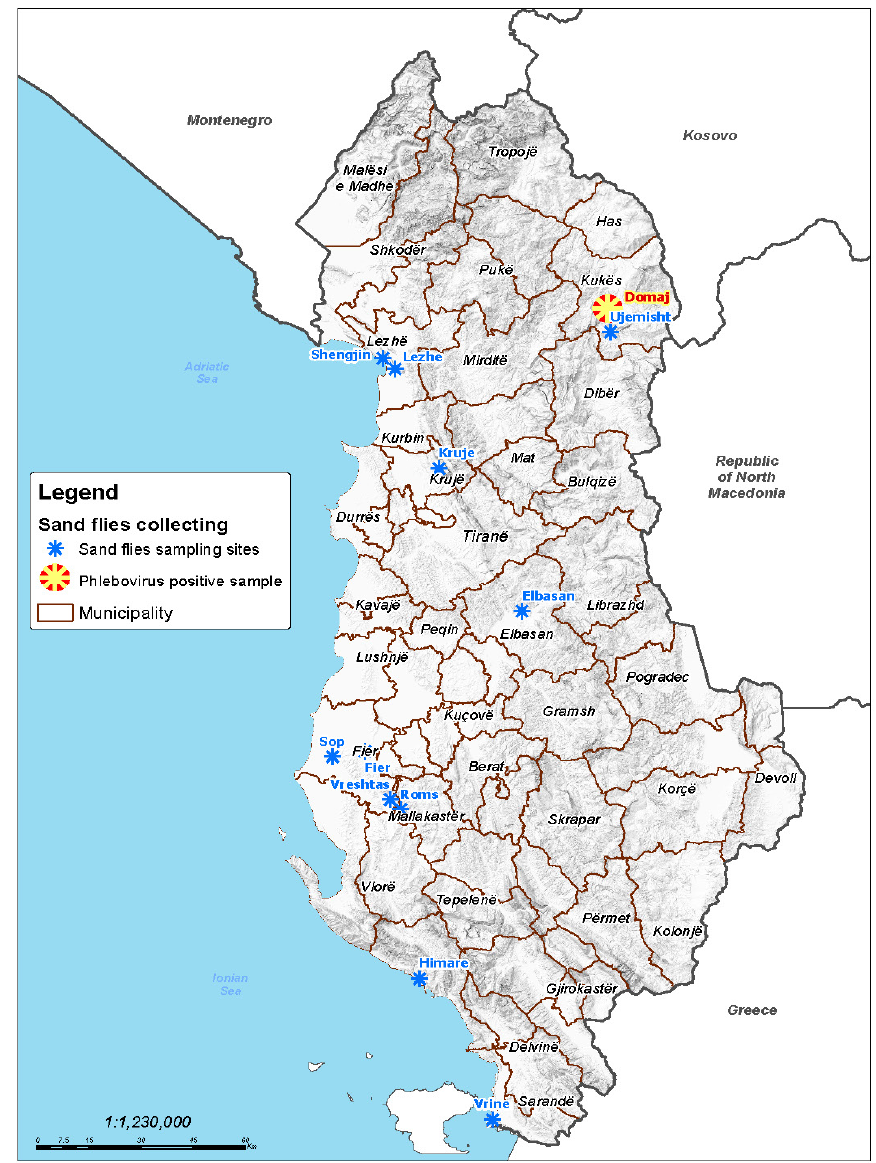
Figure 1. Sand fly sampling regions and phlebovirus positive pool location.